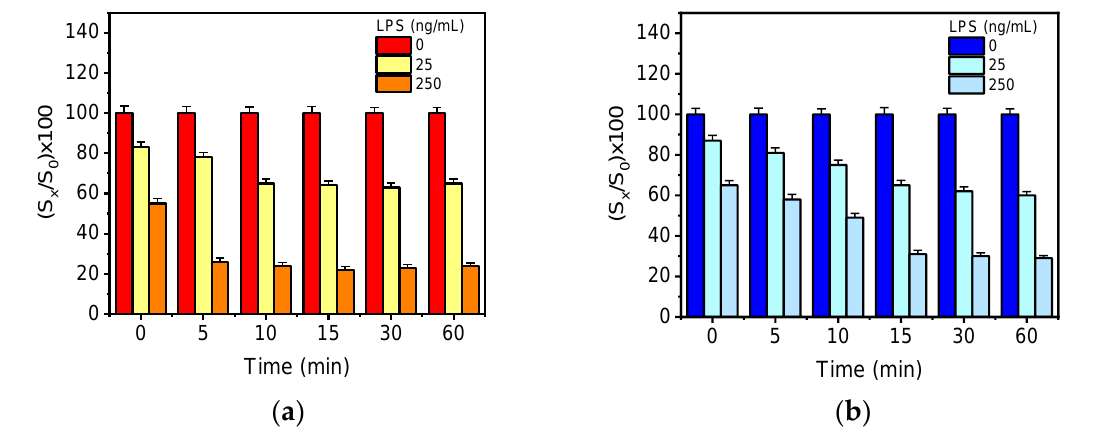
Figure 2. ( a ) Percent signal values obtained for a calibrator containing 25 (yellow columns) or 250 ng/mL of E. coli LPS (orange columns) with respect to zero calibrator (red columns) without pre-incubation and with 5-, 10-, 15-, 30- and 60-min pre-incubation of the calibrators with anti- E. coli antibody solution. ( b ) Percent signal values obtained for a calibrator containing 25 (cyan columns) or 250 ng/mL of S. typhimurium LPS (light blue columns) with respect to zero calibrator (blue columns) without pre-incubation and with 5-, 10-, 15-, 30- and 60-min pre-incubation of the calibrators with anti- S. typhimurium antibody solution. Each point is the mean value of three measurements. Error bars correspond to ±SD.